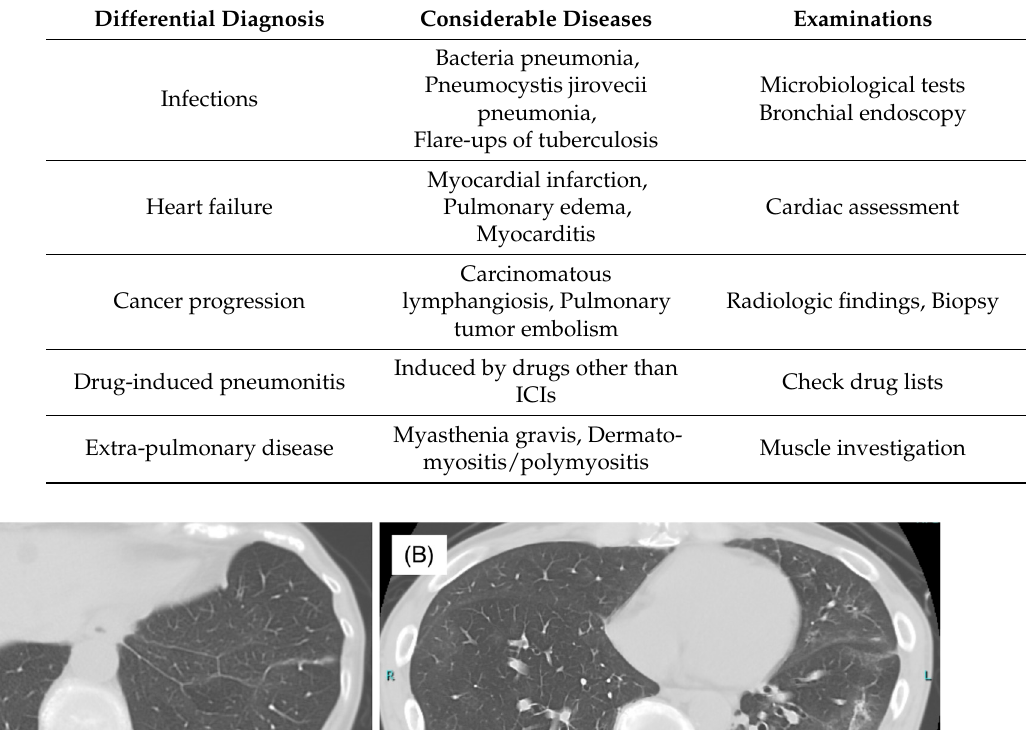
Table 1. Differential diagnosis of immune-checkpoint inhibitor (ICI)-pneumonitis.